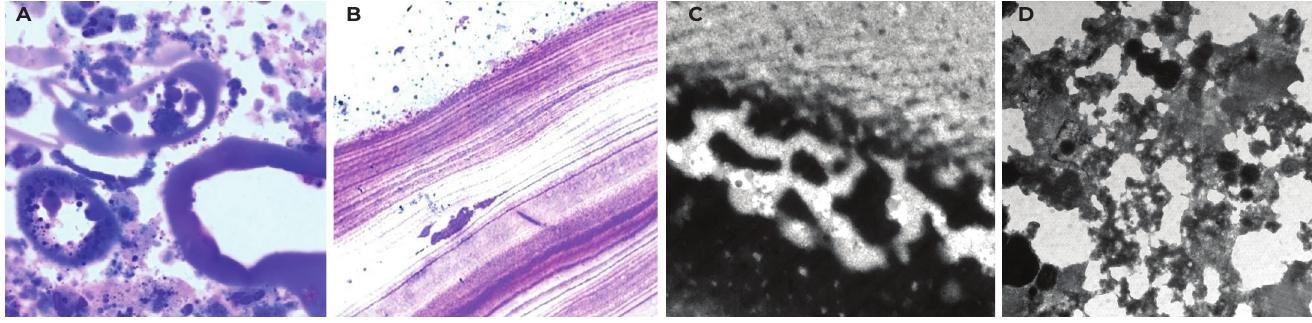
Figure 2 - Contents of echinococcal cyst 3 days after HIFU ablation. A - homogenization, laminar sheath rupture, desquamation of germinal sheath of brood capsules and larvocysts of echinococcus. Semi-thin slice x 500. B - delamination of laminar shell plates. Semi-thin slice x. 1000. C - necrosis of surface of fibrous layers, vacuolization of granular aggregates of internal layer of laminar shell plates. Electronogram x 30,000. D -destruction of glycogen-containing cell of laryngeal lamina membrane. Electronogram x 24